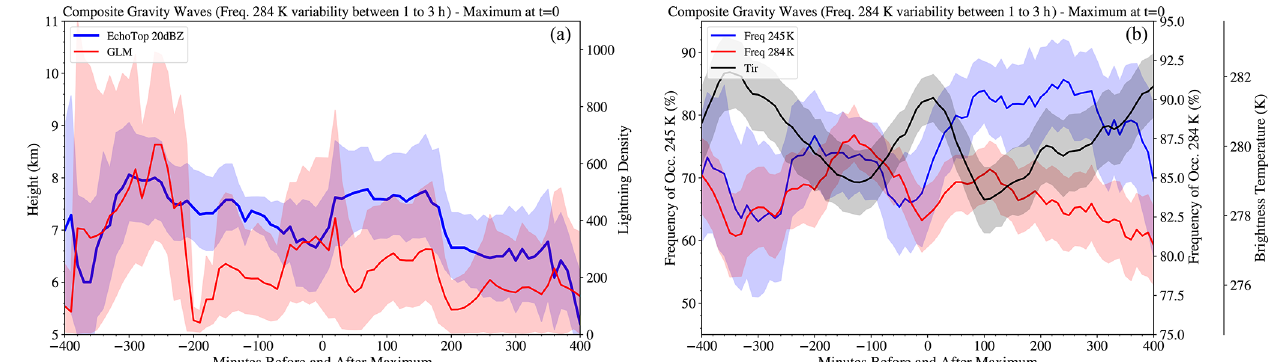
Figure 10. Composite at 400min before and after the maximum of variability in the frequency interval from 1 to 5h of the total cloud cover ( T IR < 284K). (a) Echo top and lightning density. (b) T IR , frequency of occurrence of T IR < 245K and T IR < 284K in the area of 12 by 12km 2 . The shaded area corresponds to a confidence interval of